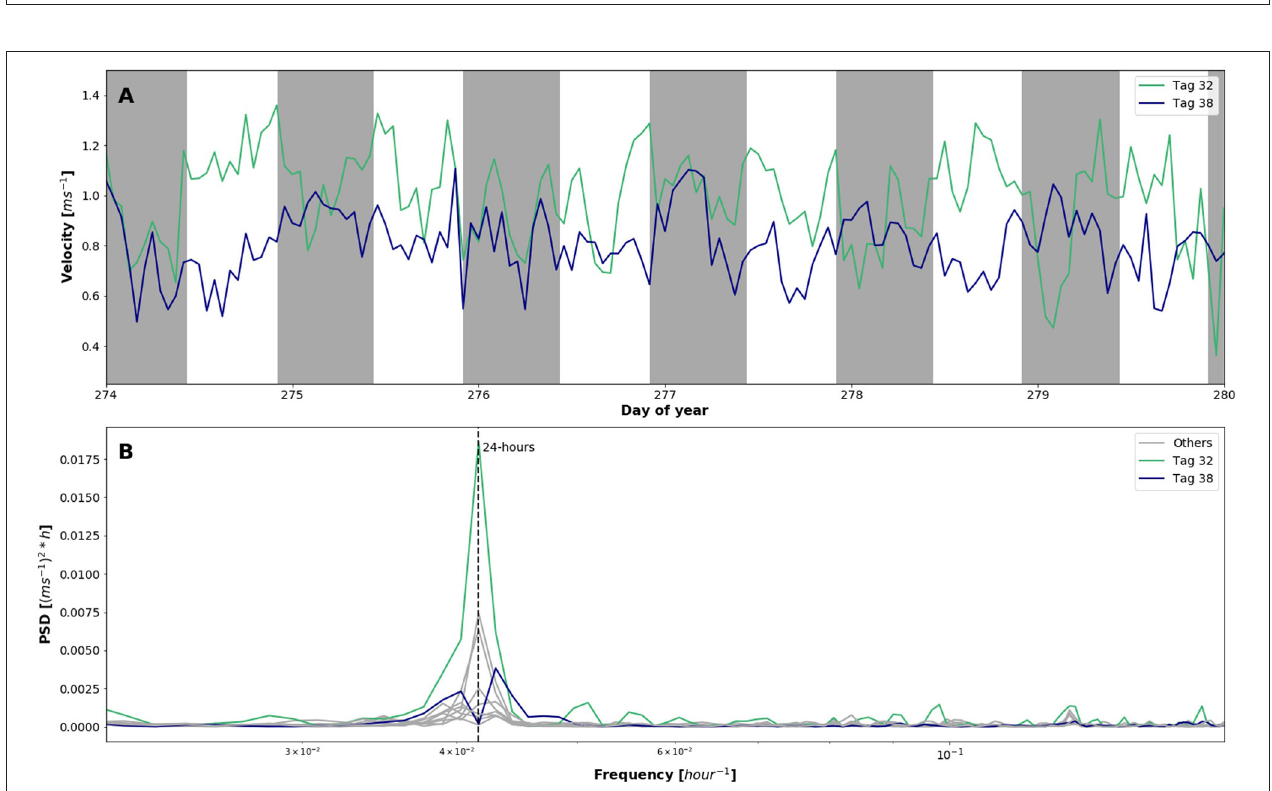
Frontiers in Animal Science |